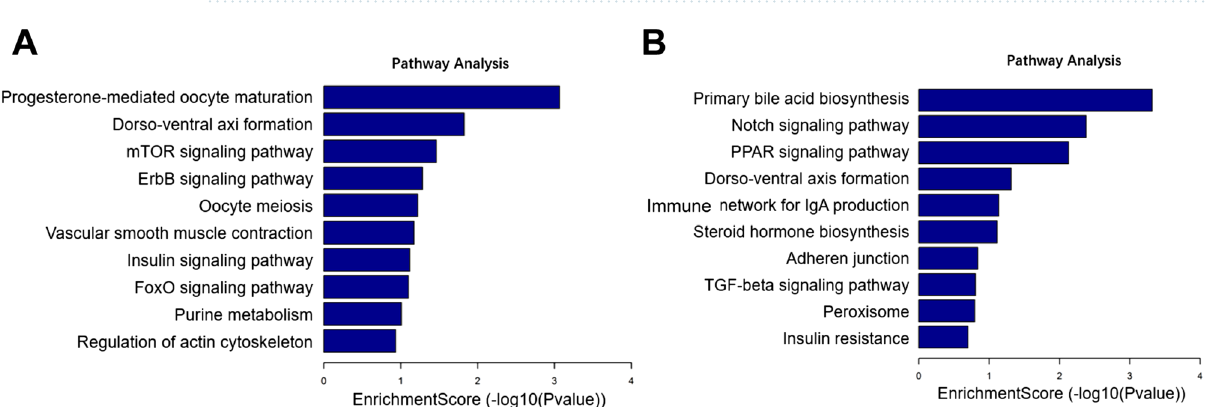
Figure 6. Gene ontology analyses of the infected and control groups. ( A ) The top ten gene ontology terms of biological processes were significantly enriched for the up-regulated genes; ( B ) The top seven gene ontology terms of cell component were significantly enriched for the up-regulated genes; ( C ) The top ten gene ontology terms of molecular functions were significantly enriched for the up-regulated genes; ( D ) The top ten gene ontology terms of biological process significantly enriched for down-regulated genes; ( E ) The top five gene ontology terms of molecular functions significantly enriched for down-regulated genes.